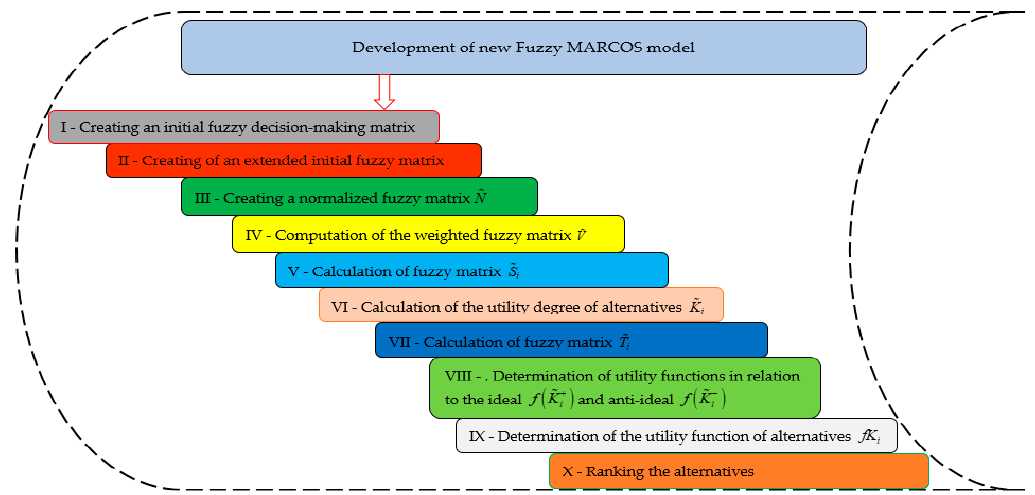
Figure 1. Algorithm of new developed fuzzy MARCOS method.